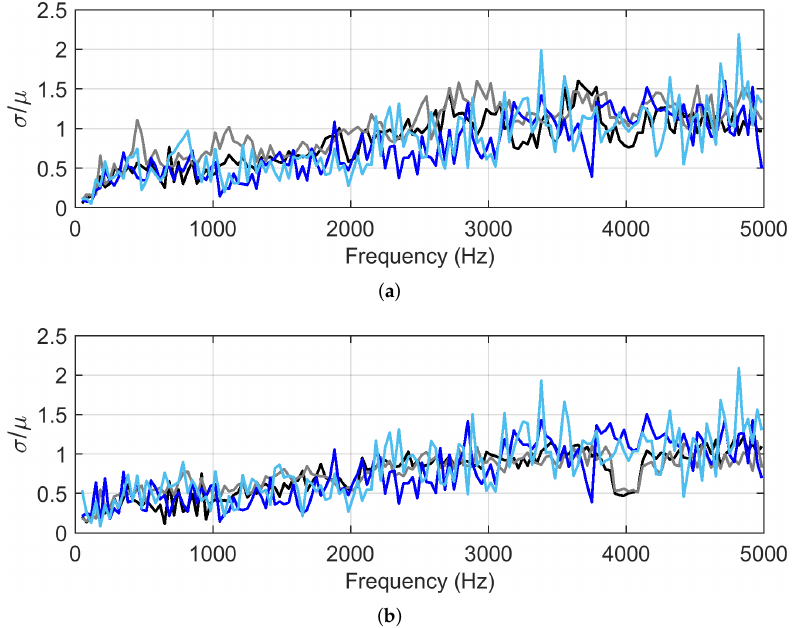
Figure 11. Normalized dispersion σ / µ , calculated out of 24 + 24 observations for traction and braking conditions for: ( a ) P h and Q h (black and grey for CH, blue and light blue for D system, respectively); ( b ) V h and I h (black and grey for CH, blue and light blue for D system,